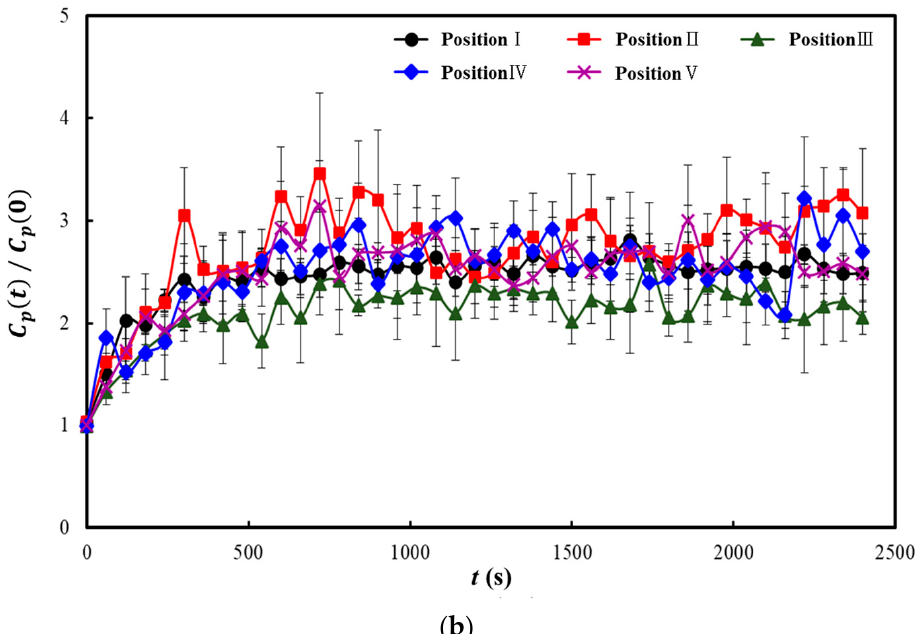
Figure 6. Comparison of the dimensionless particle number concentrations for different measurement positions according to the opening of the windows when one air purifier was operated: ( a ) Case 2; ( b ) Case 11.